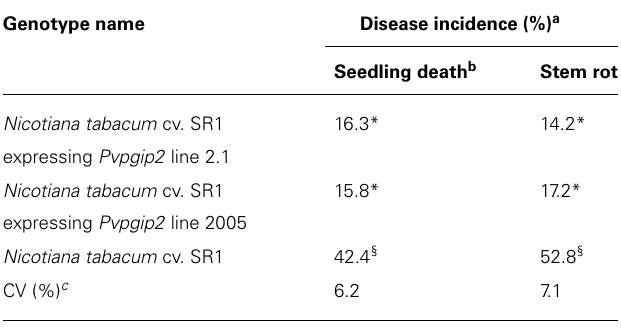
Table 1 | Reaction of tobacco plants expressing Pvpgip2 to R. solani in greenhouse conditions.